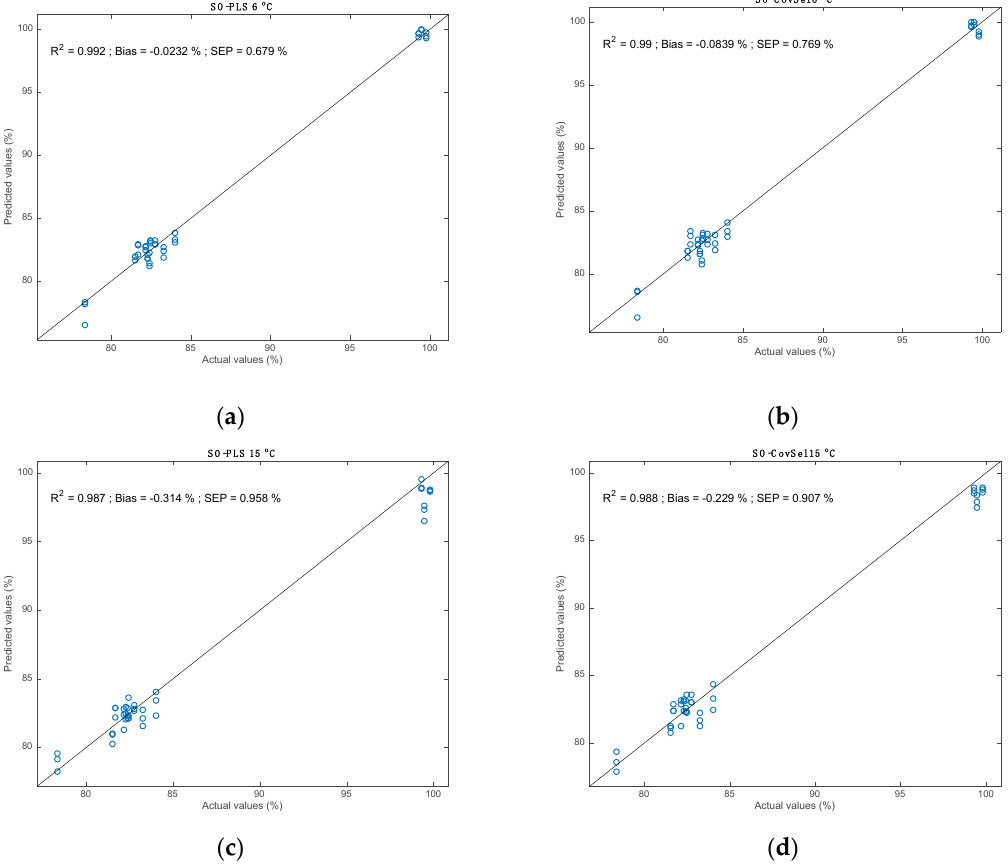
Figure 3. Predictions of F w on the test set by SO-PLS ( a , c ) and by SO-CovSel ( b , d ) for 6 °C ( a , b ) and for 15 °C ( c , d ).